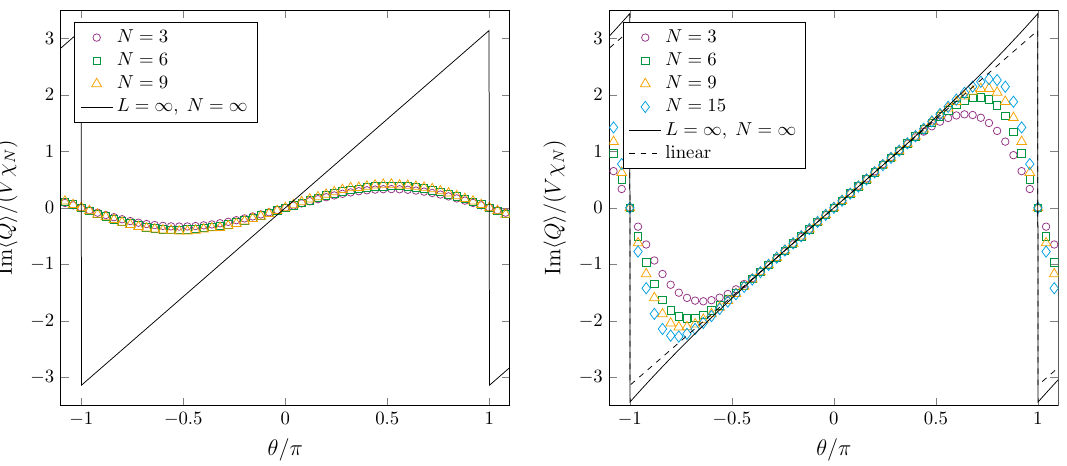
Figure 16 . The imaginary part of the topological charge density is plotted against θ for U( N ) gauge theories with various N and L = 2 , D cut = 32 using λ = 1 . 5 (Left) and λ = 3 (Right). The results for N = ∞ and L = ∞ are shown by the solid lines, which, for λ = 3 , deviates from the linear behavior represented by the dashed line in the right